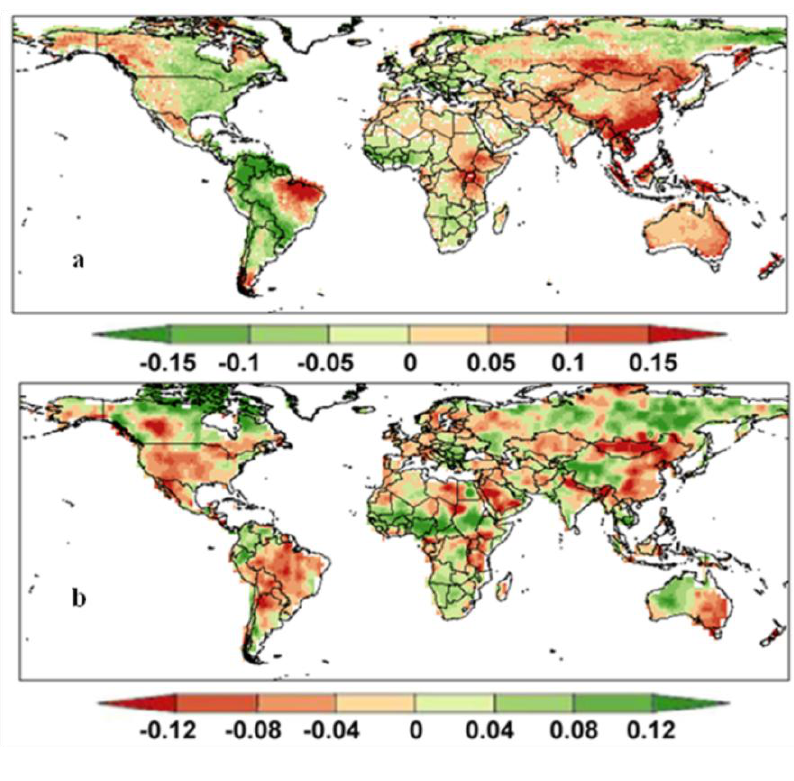
Figure 10. Spatial pattern of linear trends in annual ( a ) EDI and ( b ) PDSI, from 1984 through